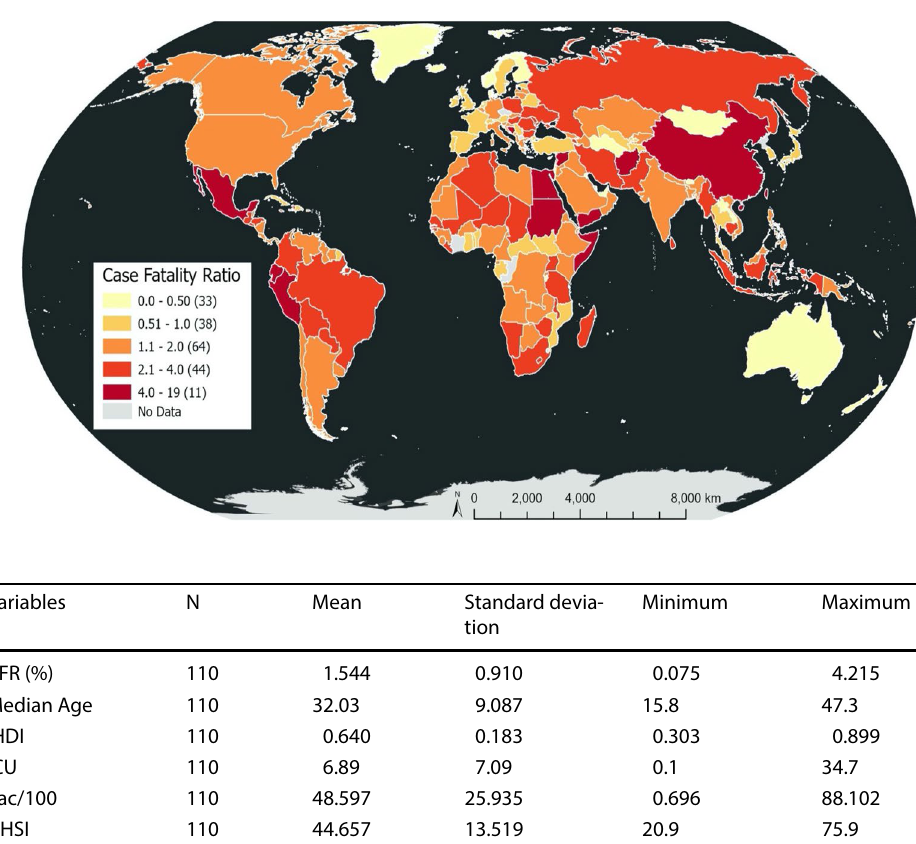
Fig. 1 Choropleth Map of COVID-19 CFR (Case Fatality Rate) for 190 countries (The number in the parenthesis refer to the number of coun- tries in the CFR range)